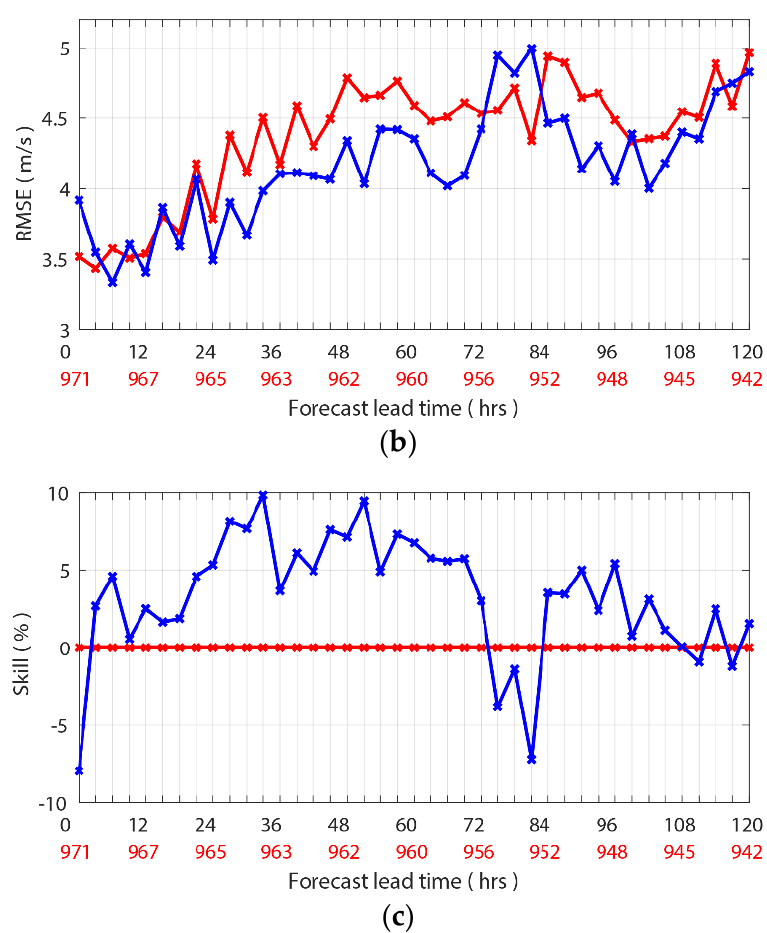
Figure 7. Performance comparison of 10 m winds relative to NDBC buoy measurements (shown in Figure 6) during Hurricane Irma landfall in Florida. ( a ) The absolute error, ( b ) root-mean-square error (RMSE), and ( c ) model skill as a function of the forecast lead time between control run and high-resolution land–sea mask.